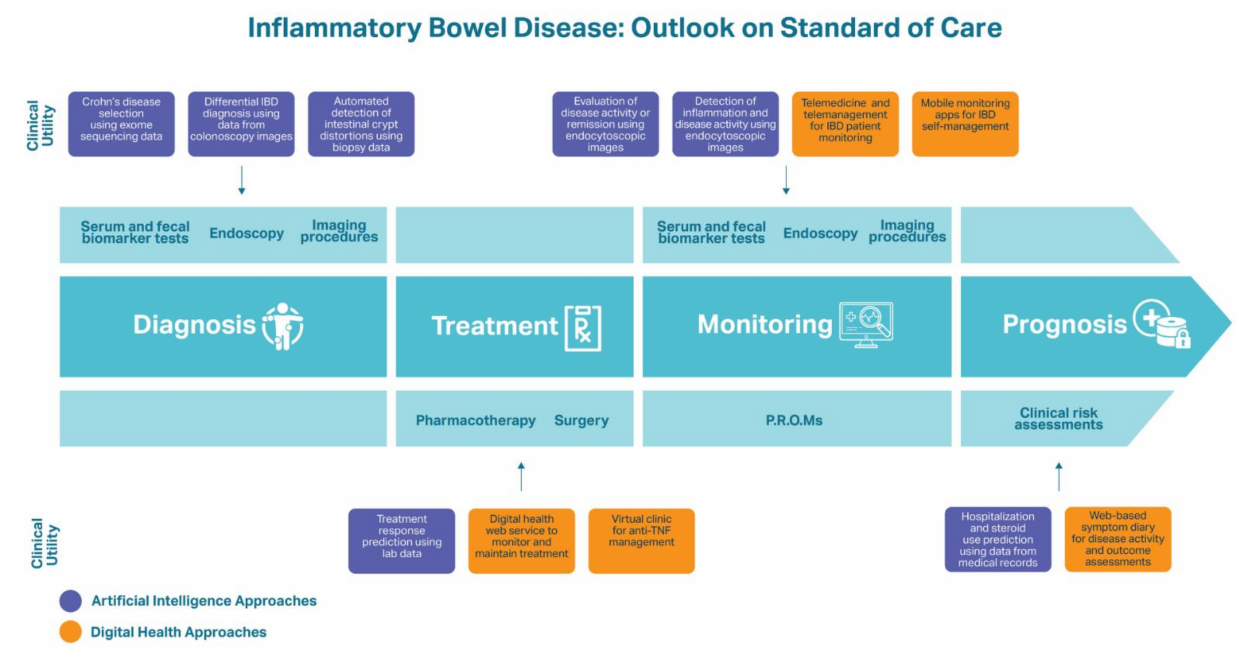
Figure 1. An overview of the traditional approaches to care for IBD patients and the novel digital health and artificial intelligence approaches